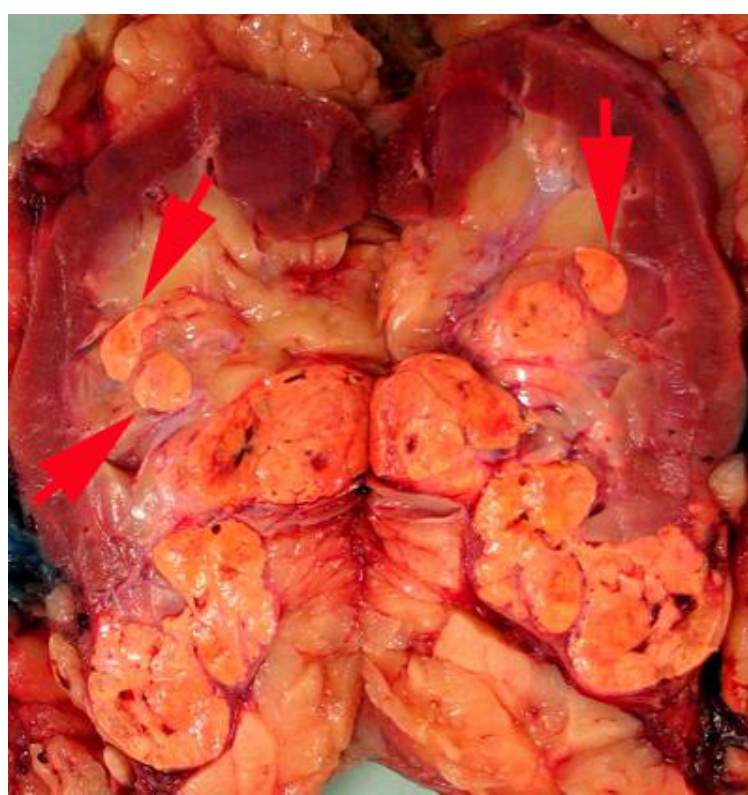
Figure 1A . Rounded nodules in the renal sinus indicate sinus vascular